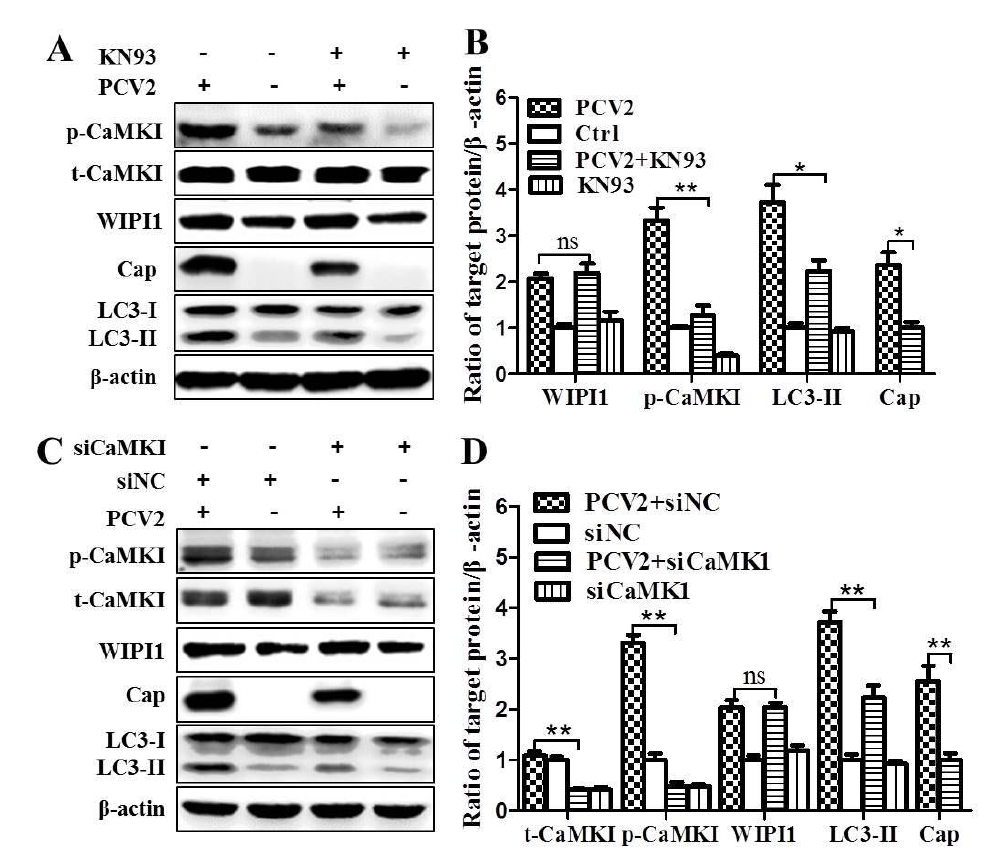
Figure 4. Inhibition of CaMKI by KN93 or RNA interference reduced expression of LC3-II and Cap proteins without affecting WIPI1. PK-15 cells were infected with PCV2 (MOI ≈ 1) in the presence of KN93 (2 μM) or siRNA targeting CaMKI (siCaMKI). Cells were collected at 36 hpi and the lysates were subjected to Western blotting. ( A ) Representative images of Western blotting for target proteins from cells treated with KN93; ( B ) Ratios of WIPI1, p-CaMKI, Cap and LC3-II to β-actin; ( C ) Representative images of Western blotting for target proteins from cells treated with siCaMKI; ( D ) Ratios of WIPI1, t-CaMKI, p-CaMKI, Cap and LC3-II to β-actin. Ratios of targeted proteins to β-actin were normalized to mock infection set at 1.0. Data are reported as the mean ± SEM of three independent experiments (ns p > 0.05; * p < 0.05; and ** p < 0.01).